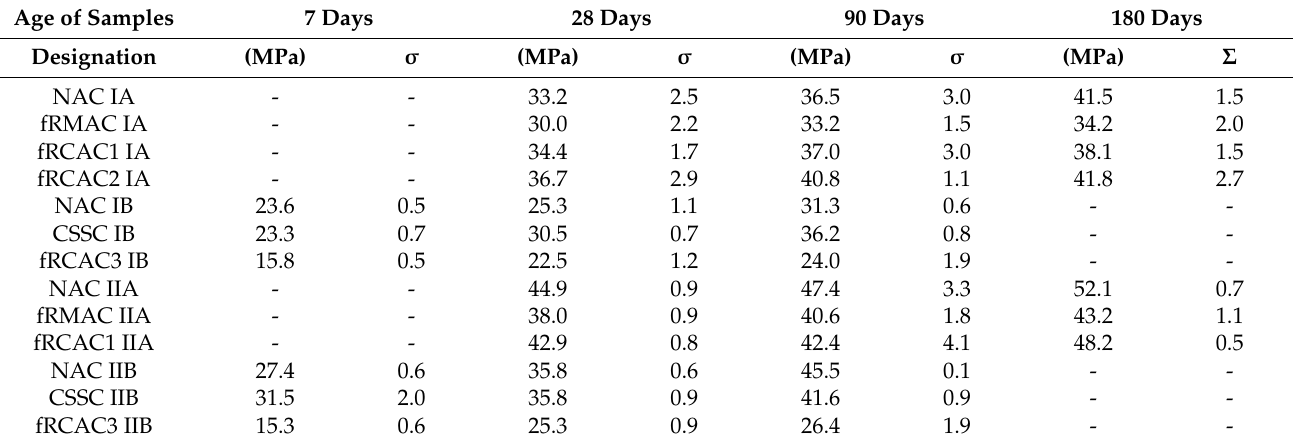
Table 7. Average values of results of long-term compressive strength development, including standard